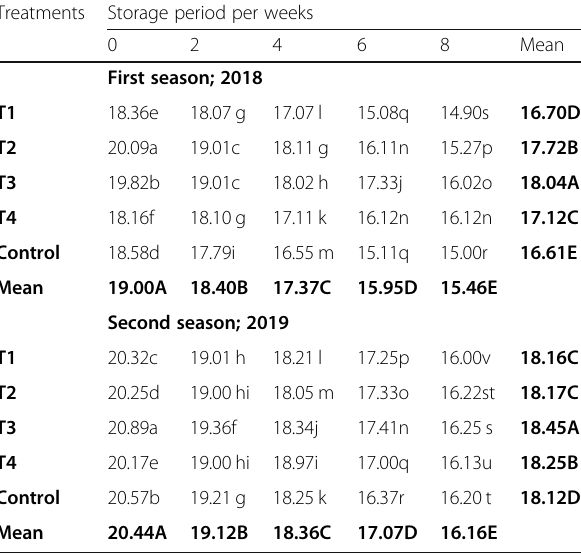
Table 7 Effect of preharvest spraying with moringa leaf extract, boric acid, and chelated calcium on total flavonoid content of Hollywood plum fruits stored at 0 ± 1 °C and RH 85 – 90% during